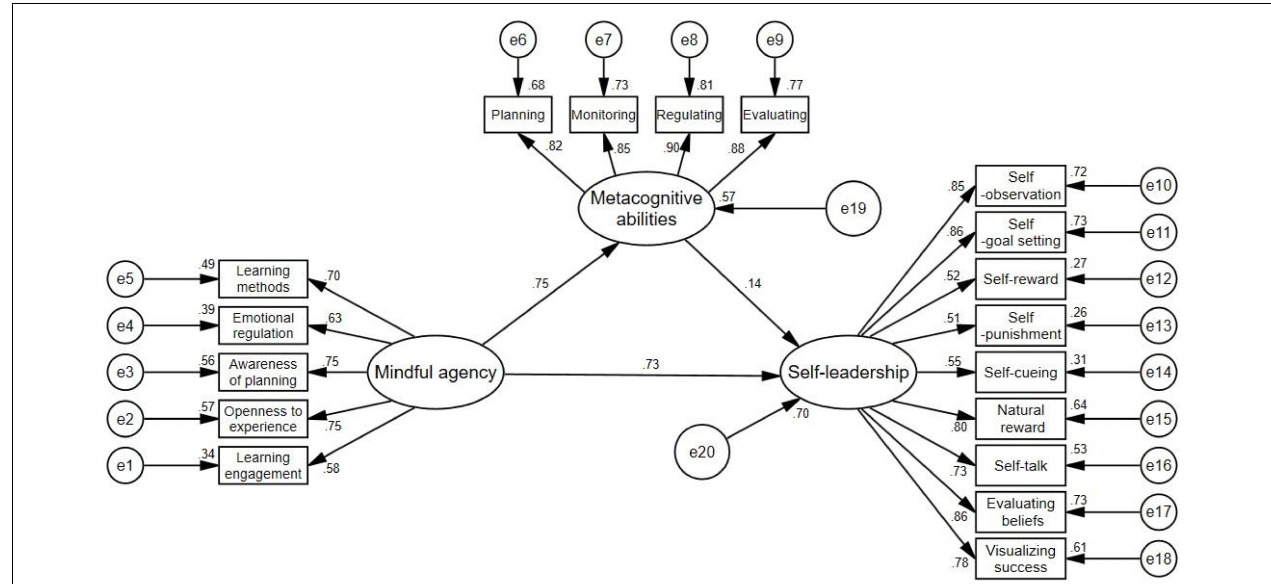
FIGURE 2 | Structural equation model of mindful agency, metacognitive ability and self-leadership ( n = 1,244).